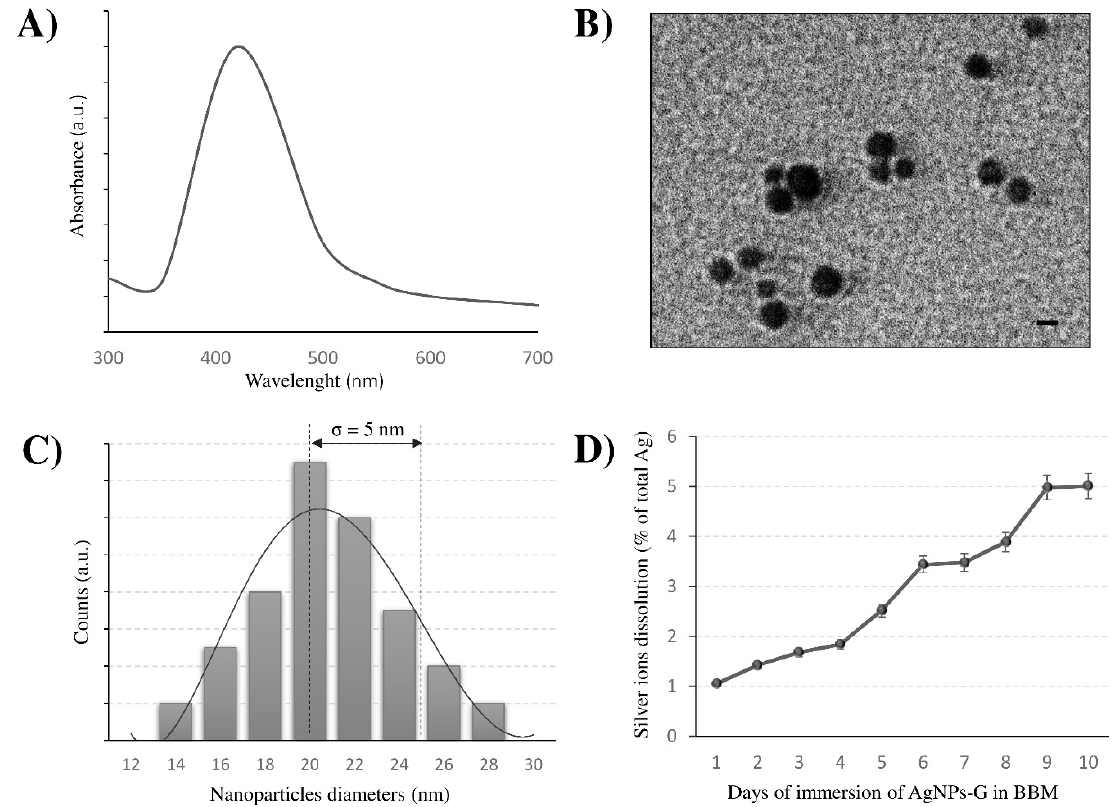
Figure 1. ( A ) Ultraviolet (UV)–visible spectra of glucose-capped silver nanoparticles (AgNPs-G) / mL in Bold’s basal medium (BBM) culture medium reported as absorbance in arbitrary unit (a.u., y axis) vs. wavelength (nm, x axis). ( B , C ) Size distribution and transmission electron microscopy (TEM) micrograph of AgNPs-G. Size distribution is reported as arbitrary unit (a.u., y axis) vs. longitudinal diameter (nm, x axis). Bars = 20 nm. ( D ) Kinetic of Ag + dissolution. The dissolution of AgNPs-G in complete BBM culture medium was evaluated by atomic absorption spectroscopy. Data were analysed by performing one-way analysis of variance (ANOVA) at the 95% confidence level. Each value represents the mean ± standard deviation (SD) of 3 technical replicates in each of the 3 independent experiments. Ag + dissolution degree is expressed as percentage (%) of total AgNO 3 used to obtain the highest concentration of NPs solution during treatment.